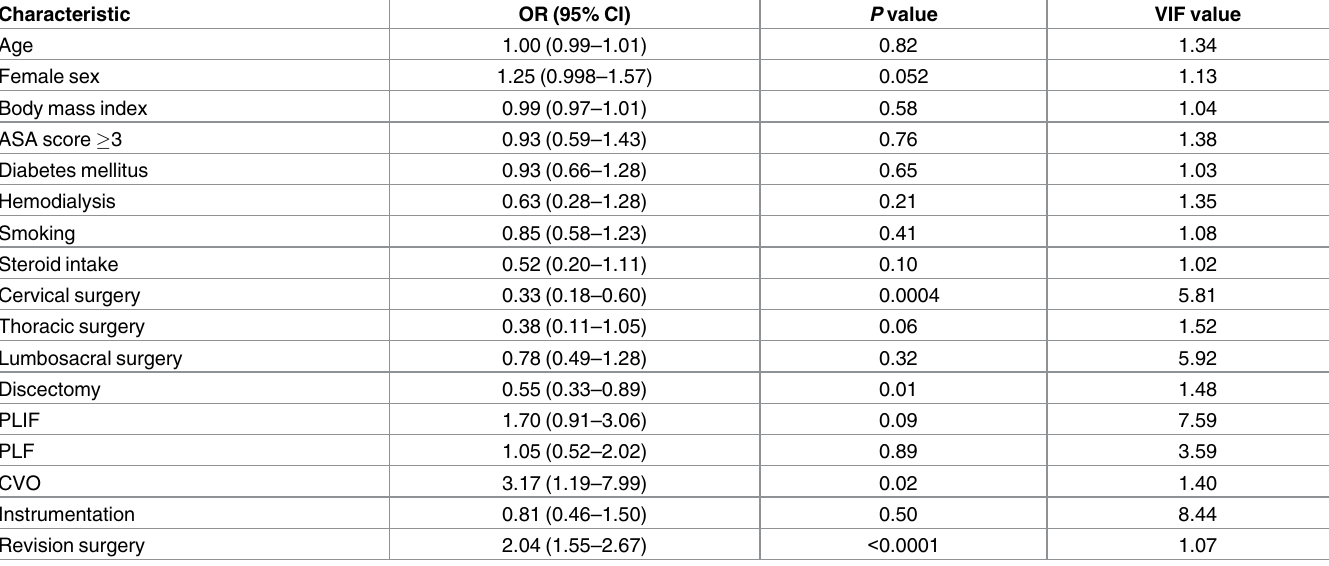
Table 3. Multivariable logistic regression analyses for ID during posterior open spine